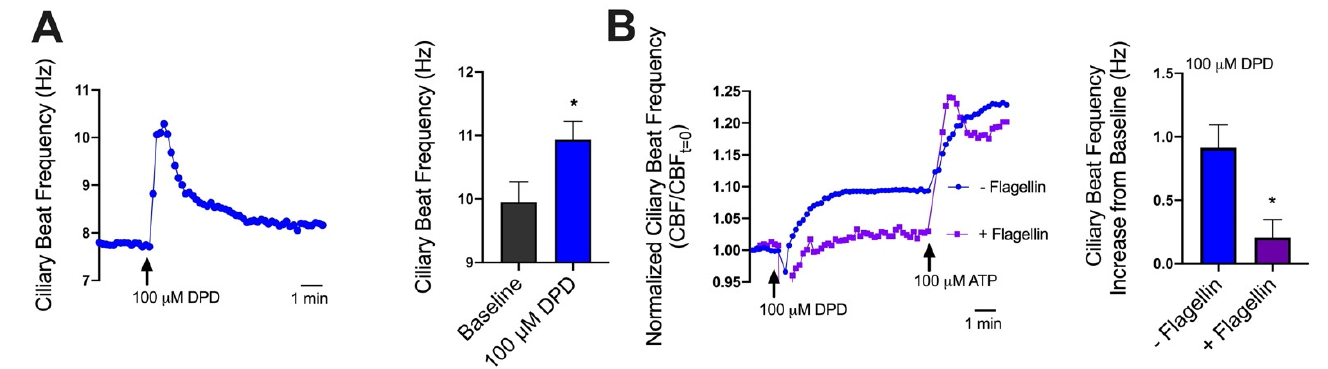
Figure 5. Flagellin represses DPD enhancement of ciliary beat frequency. ( A ) T2R14 agonist diphenhydramine (100 µM) increases CBF by up to 1 Hz. ( B ) Fully differentiated (day 21) nasal ALI cultures were treated with media containing 0.1 µg/mL flagellin for 72 h to ensure reduction in both RNA and protein expression. Flagellin-treated cultures did not reveal a 1 Hz increase in CBF when treated with diphenhydramine. Traces are from 1 patient representative of results from ≥ 3 patients. Bar graphs are combined data from a ≥ 3 ALIs from ≥ 3 individual patients.